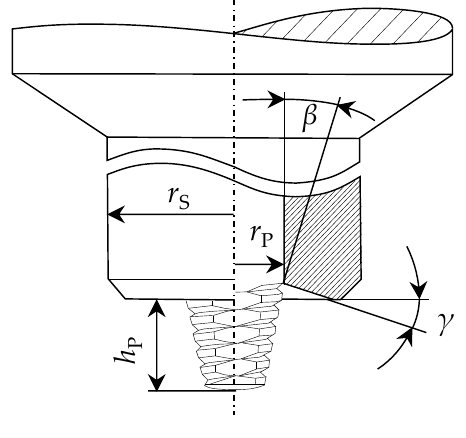
Figure 1. Tool geometry.